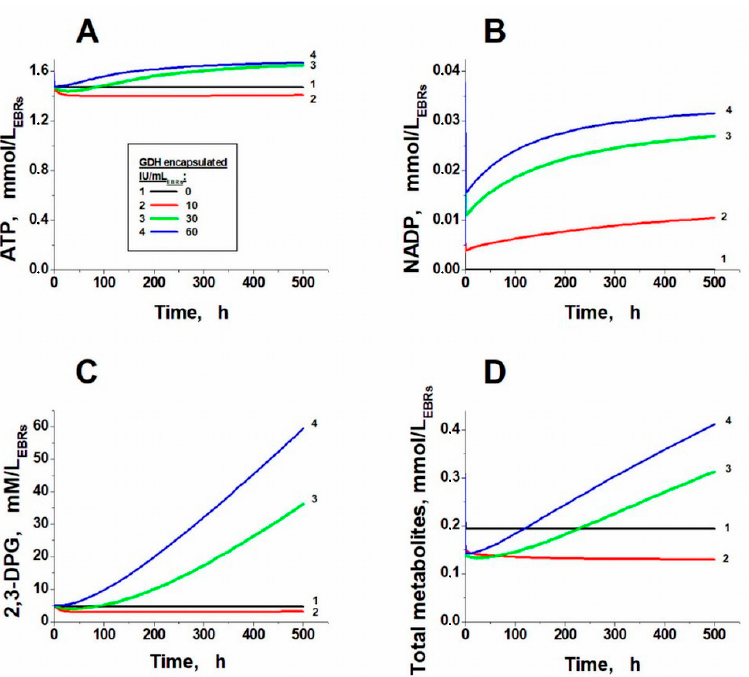
Figure 2. Kinetics of glycolysis metabolites in erythrocyte-bioreactors (EBRs) with different activities of encapsulated ammonium-neutralizing enzymes. Concentrations of ATP ( A ), NADP ( B ), 2,3- diphosphoglycerate (2,3-DPG) ( C ), and the sum of concentrations of glycolysis metabolites from G6P to phosphoenolpyruvate (PEP) (except 2,3-DPG) ( D ). The GDH activity was 0, 10, 30, or 60 IU/mL EBRs for curves 1, 2, 3, and 4, respectively. The AAT activity was 5 times higher in each case. The kinetics of ATP, NADP, 2,3-DPG, and the total concentration of other glycolytic metabolites (from G6P to PEP excluding 2,3-DPG) are shown in Figure 2. These kinetics are different at different activities of encapsulated GDH. At sufficiently low activities of the incorporated GDH (for example, 10 IU/mL EBRs , curves 2), the changes in these concentrations in comparison with the corresponding stationary concentrations of these metabolites in the erythrocytes without encapsulated enzymes (curves 1) are